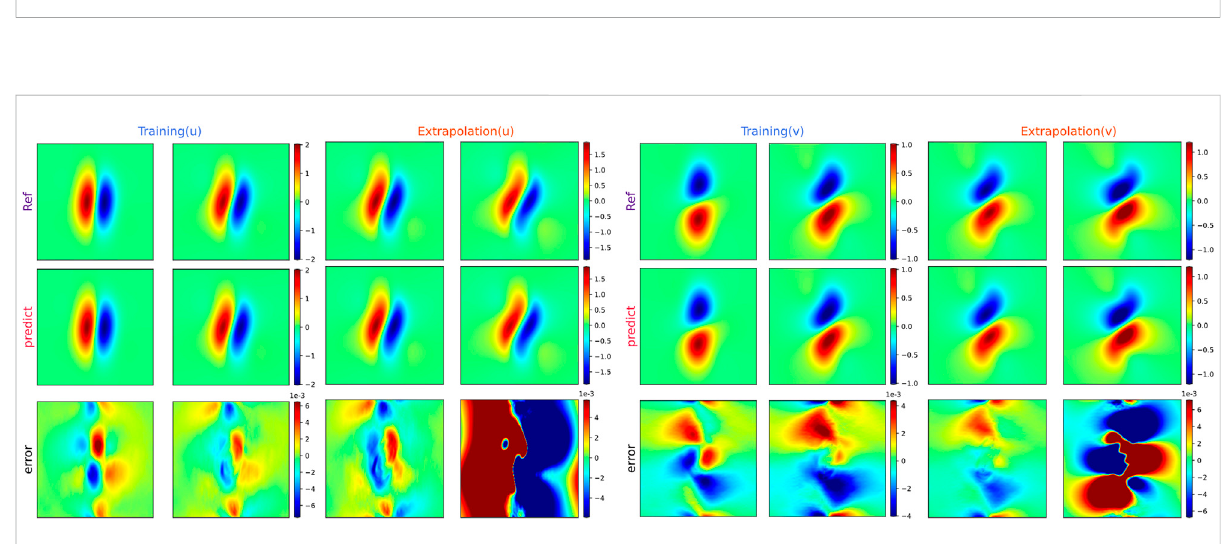
The velocity results for solving the vorticity equation with Fourier fi lter-based PhyCRNet. Four representative moments are selected for comparison, presenting the training (t = 0.025, 0.075 s) and extrapolation (t = 0.125, 0.175 s) maps, and compare the errors of the entire interval. From top to bottom are reference solutions, predictions and